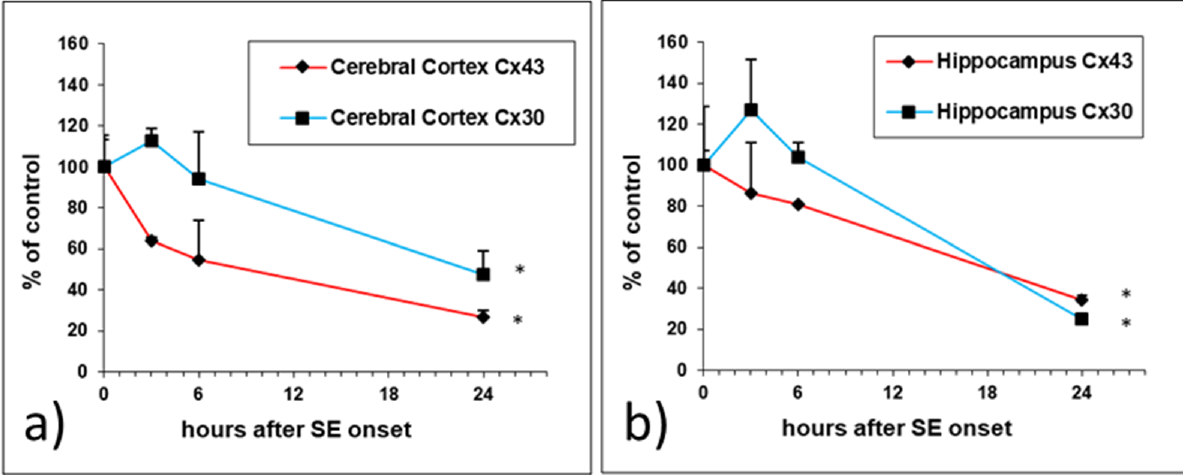
Figure 2. ( a , b ) Cx43 and Cx30 mRNA levels measured by quantitative real-time RT-PCR in the cerebral cortex ( a ) and hippocampus ( b ) at 3 h, 6 h, and 24 h after the onset of pilocarpine-induced seizures lasting 3 h. The results are expressed as a percentage of the control and are the mean ± SEM ( n = 3). * p < 0.05 versus the control.